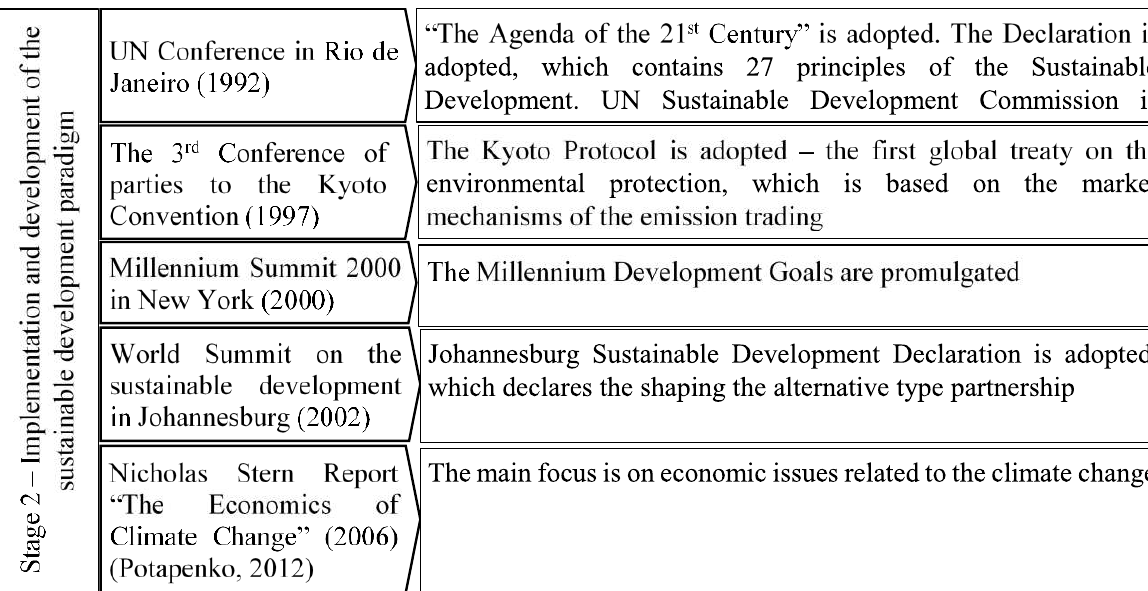
Fig. 2. Evolution of the implementation and development of the sustainable development paradigm (the second stage – 2000 –